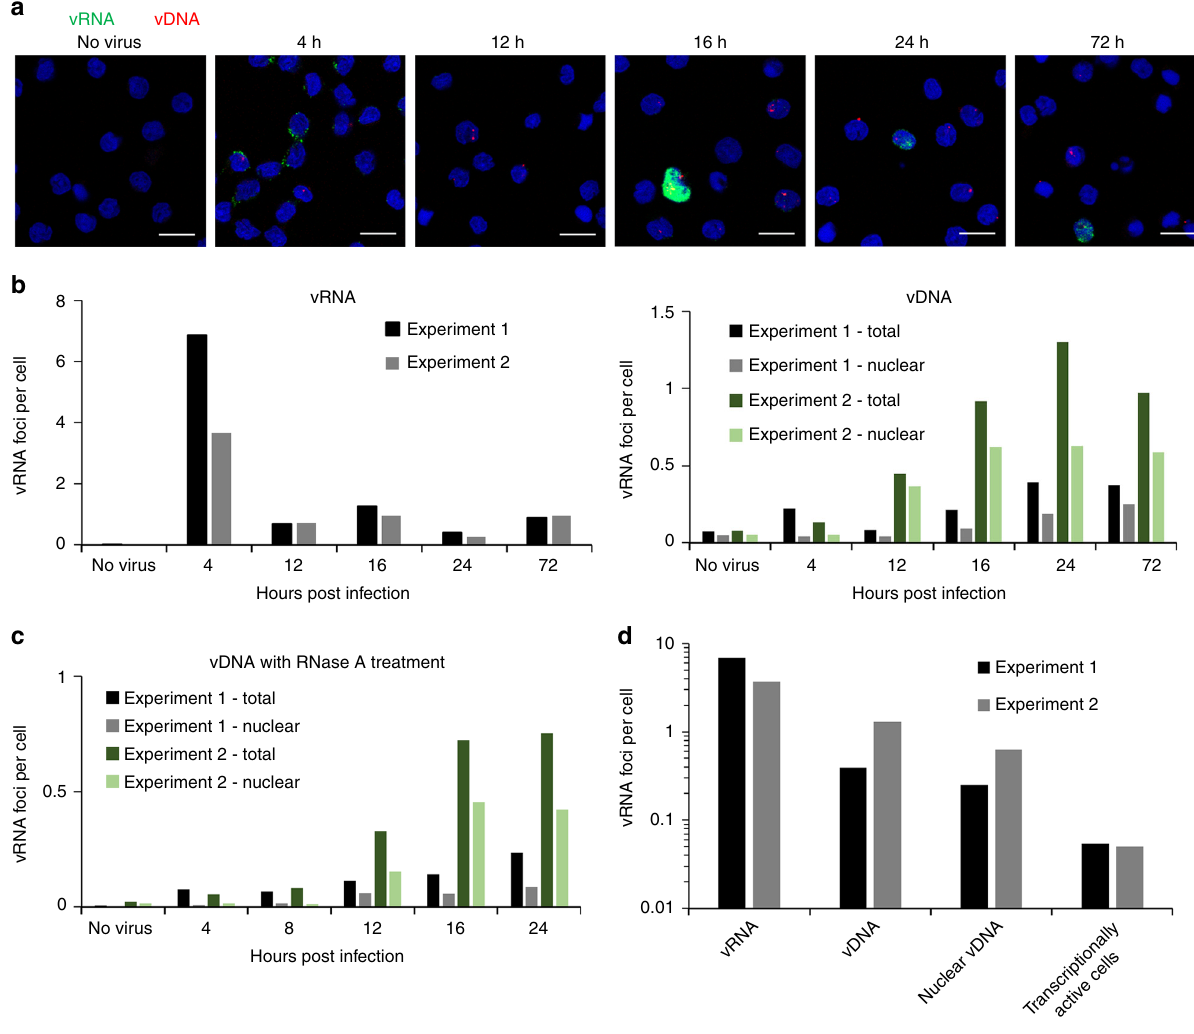
Fig. 6 Tracking the early stages of infection of Primary CD4+ T cells. Primary CD4+ T cells were isolated from PBMCs, activated, and infected with HIV-1 NL4 – 3 at an MOI of 0.05. Cells were then fi xed and stained at the indicated times. a Cells were stained for vRNA (PS-4; green), vDNA (PS-3; red) and nuclei (blue). Foci of vRNA and vDNA were counted in 1500 – 3500 cells per time point (4 – 24 h) or 500 – 1000 cells (no virus control and 72 h). Foci were counted in the complete fi eld of view (whole cell), or within a nuclear mask (nuclear). b Number of vRNA and vDNA foci per cell of two independent experiments were calculated. Number of total vDNA foci or vDNA foci within nuclei (nuclear) are also shown. c Staining of vDNA was repeated with RNase A treatment. d Peak values for foci of vRNA, vDNA, nuclear vDNA, and transcriptionally active cells were calculated, to allow determination of the ef fi ciency of each stage in the infection process. Scale bars represent 10 µ